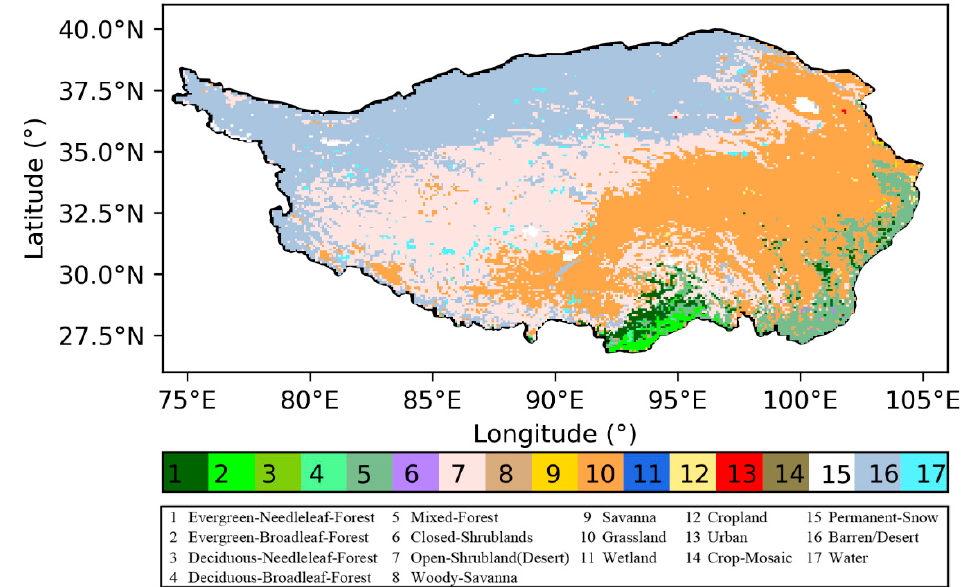
Figure4. Figure 4. The International Geosphere-Biosphere Programme (IGBP) land cover type on the Tibetan Plateau.